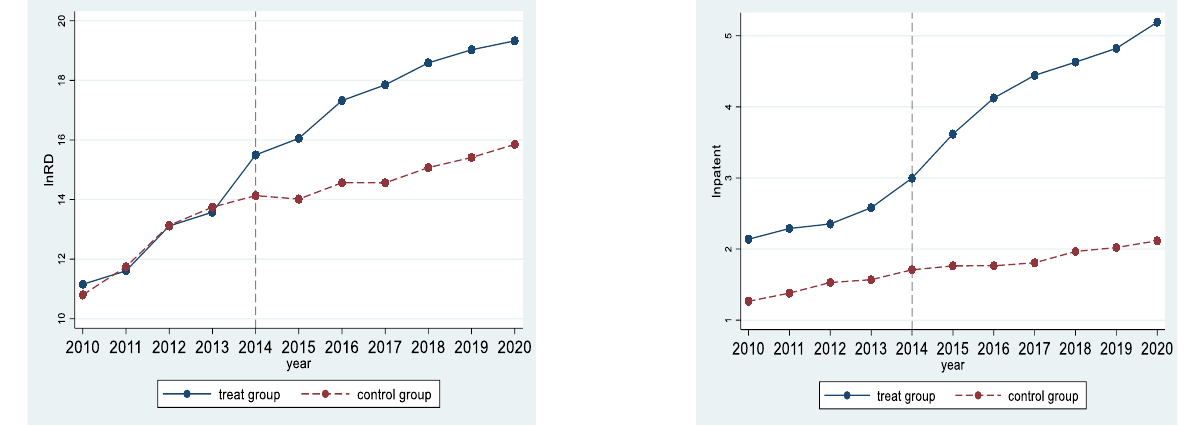
Figure 6. The time change trend in enterprise R&D technological